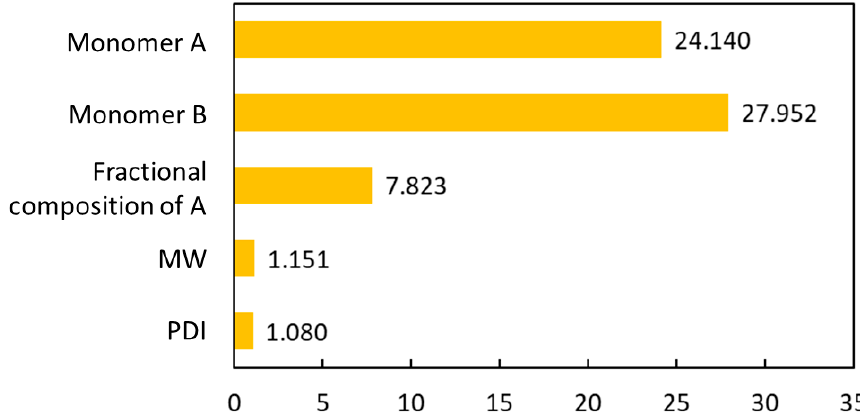
Figure 6. The bar plot of the importance factors of each input variable to the DNN model.